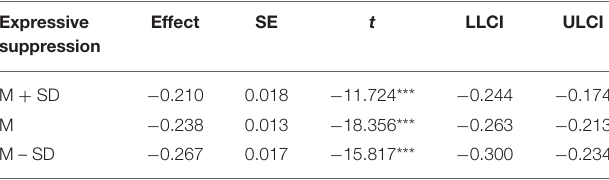
TABLE 5 | Conditional indirect effects of expressive suppression on hope. Expressive